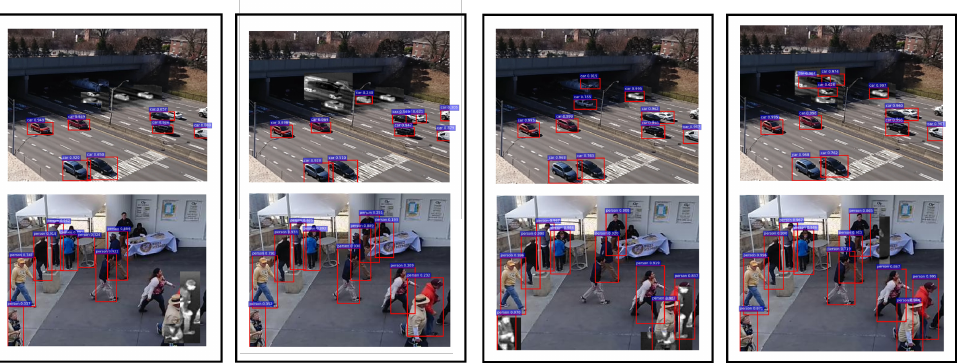
Figure 14. Comparison of confidence-driven and uncertainty-driven control on CAMEL Dataset. Top Row: Seq 09. Bottom Row: Seq 03. Columns from left to right: confidence-driven (output at sensor), uncertainty-driven (output at sensor), confidence-driven (output at end user), and uncertainty-driven (output at end